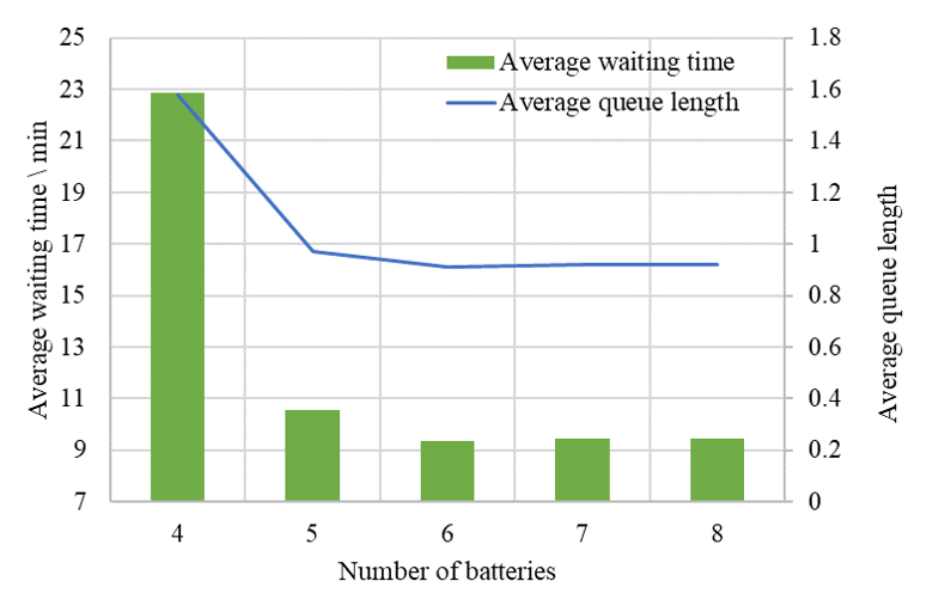
Figure 10. The impact of battery quantity on service